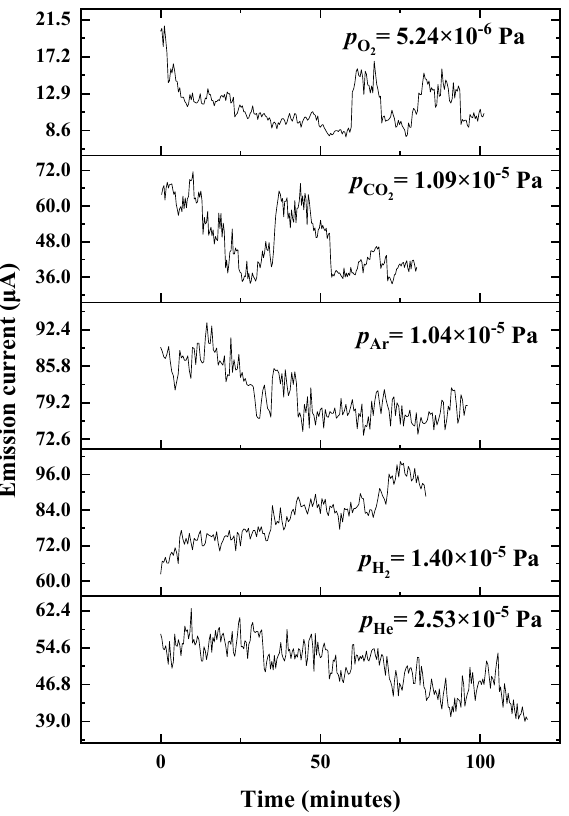
Figure 5. Emission current as function of operation time in He of 2.53 × 10 − 5 Pa, H 2 of 1.4 × 10 − 5 Pa, Ar of 1.04 × 10 − 5 Pa, CO 2 of 1.09 × 10 − 5 Pa, and O 2 of 5.24 × 10 − 6 Pa.